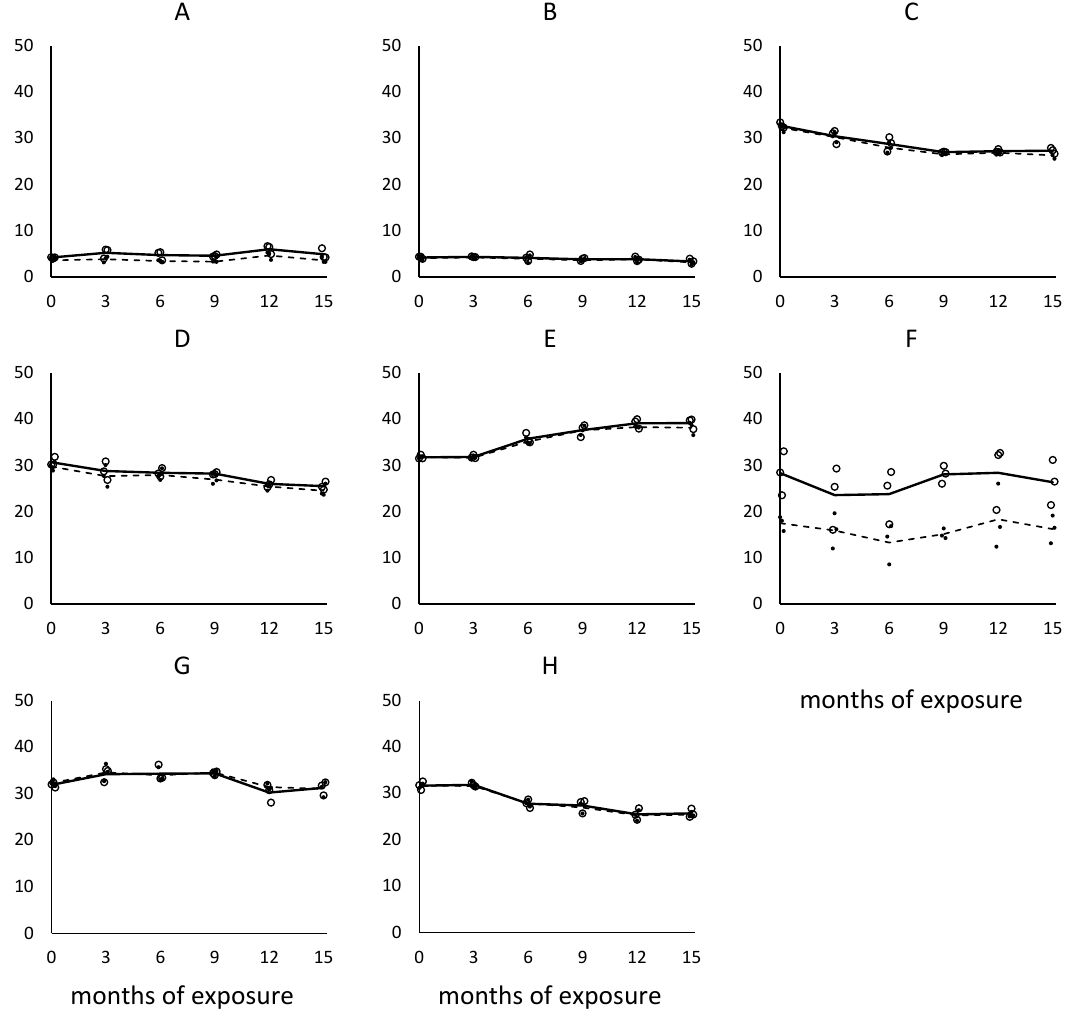
Figure 3. Gloss changes of acetylated wood samples exposed to natural weathering (note: solid line–gloss along fibres, dash line–gloss perpendicular to fibres). A–H: sample